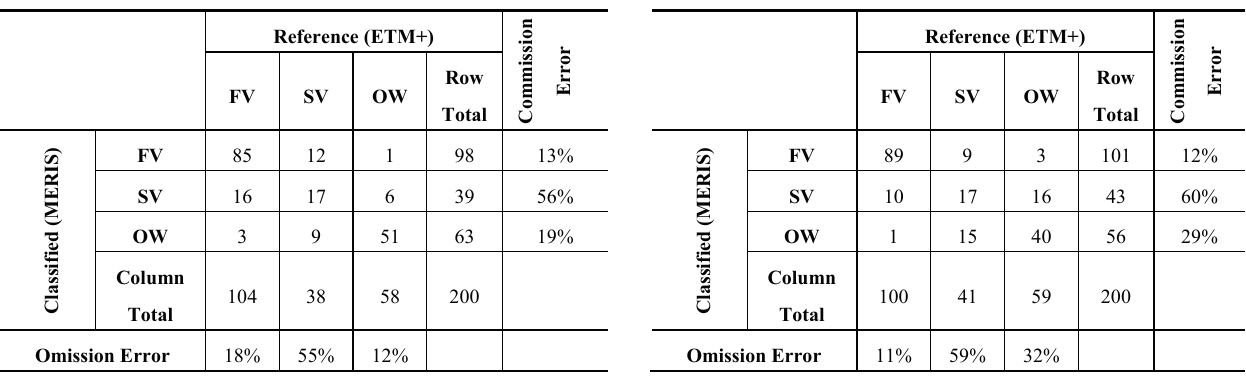
Table 3. Error matrices for image pair 1 ( left ) and pair 2 ( right ) showing classification performance of NDVI sliced into floating vegetation (FV), sparse vegetation (SV) and open water